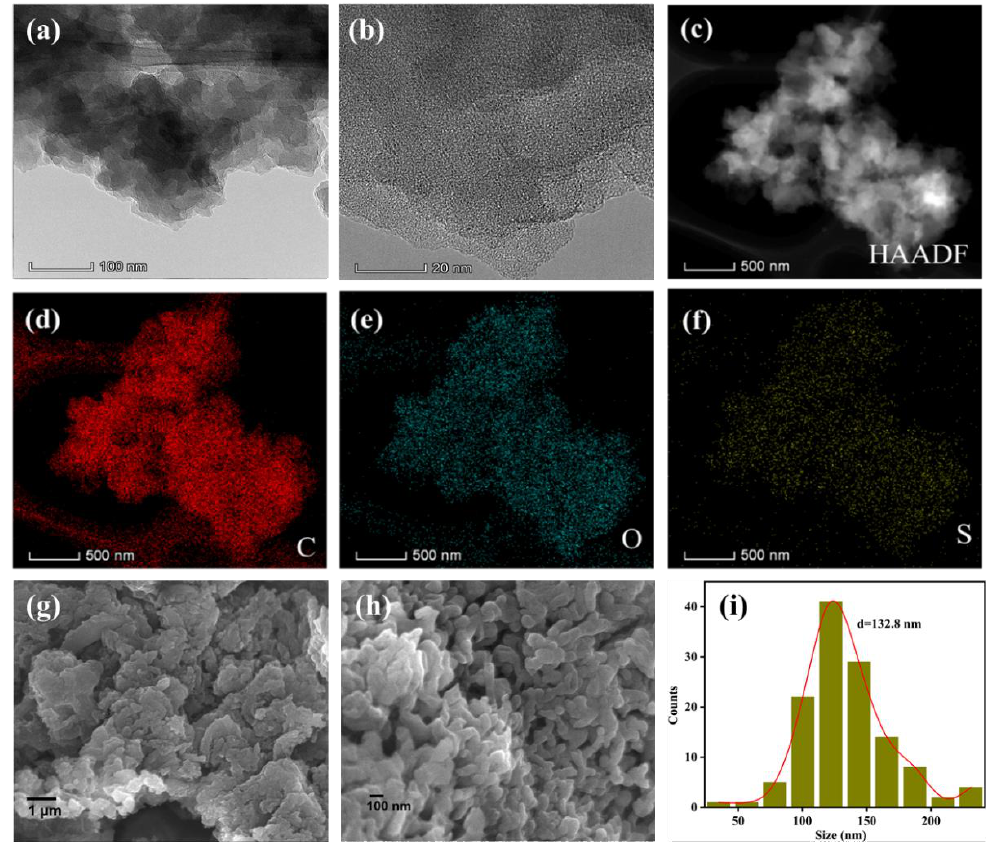
Figure 4. ( a , b ) HR-TEM images of TPC – S; ( c ) HAADF-STEM image of TPC – S; ( d ) C, ( e ) O, and ( f ) S element mappings; and ( g – i ) SEM images of TPC – S.